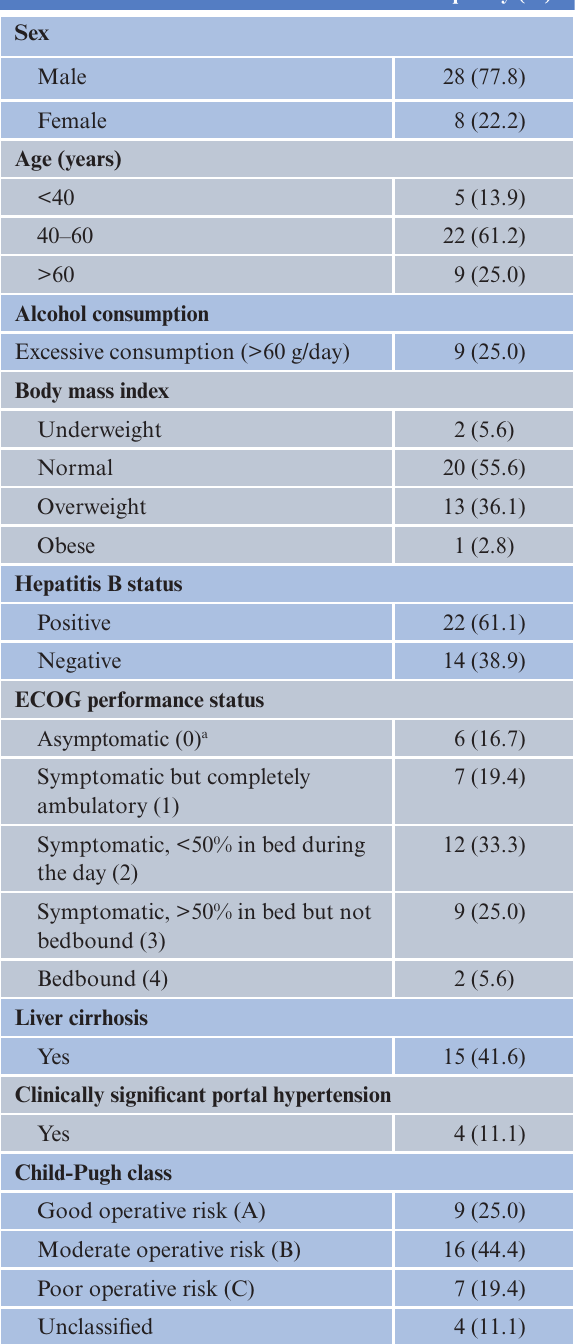
Table 1: Sociodemographics and clinical characteristics.